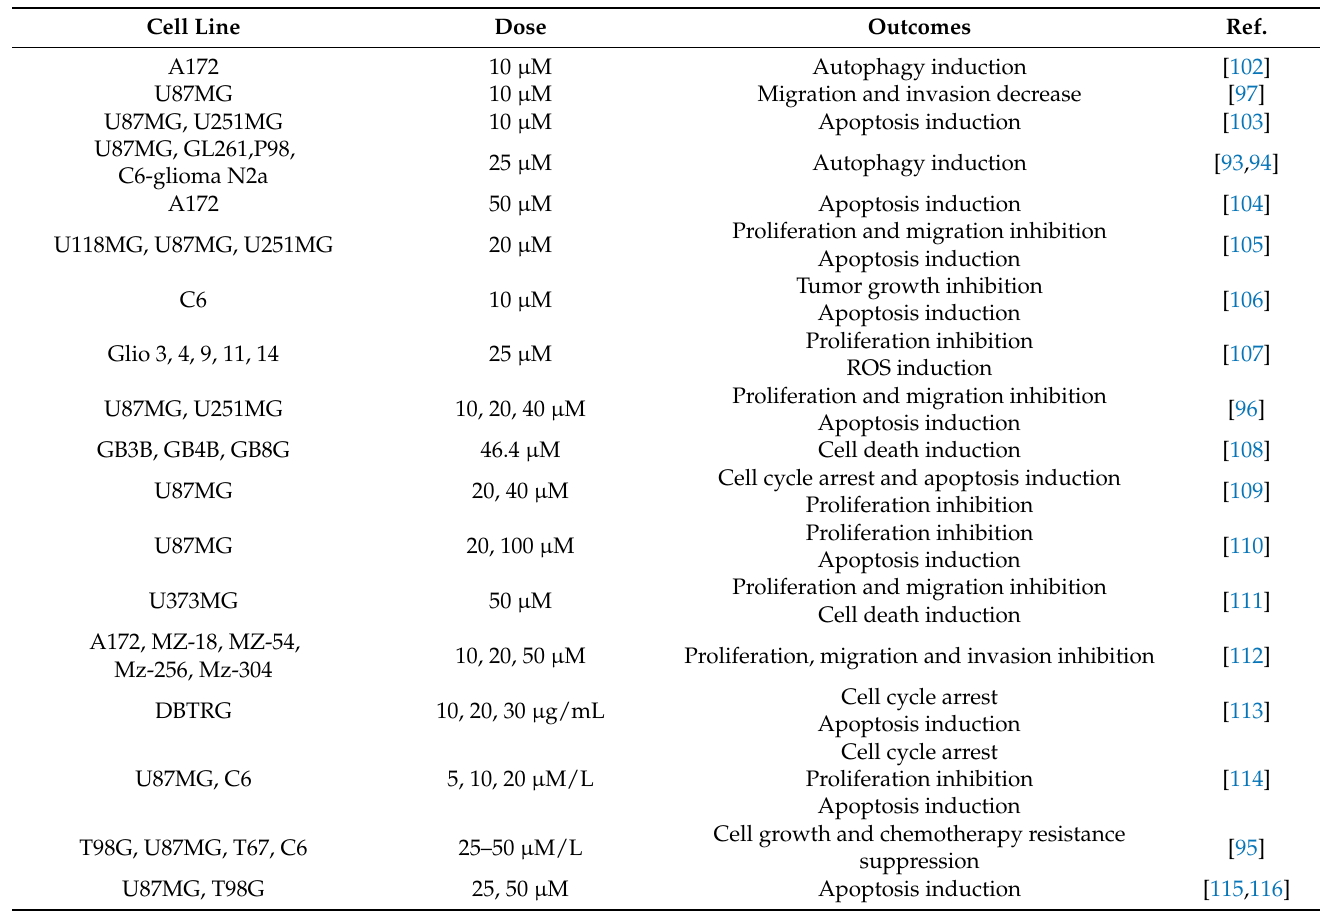
Table 4. Anti-tumor effects of curcumin on glioblastoma cell